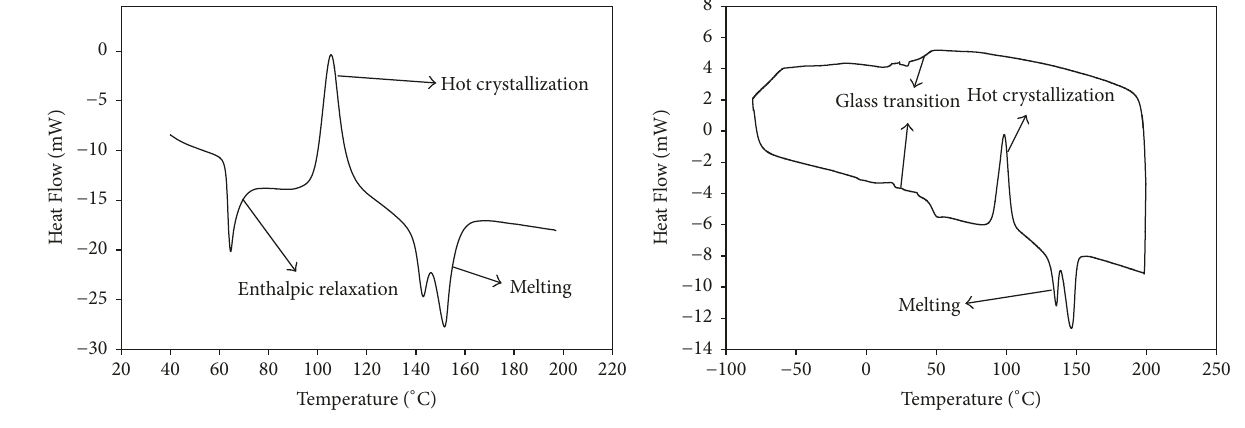
(b) DSC heating-cooling thermogram of PLA-date pits (70/30) blend